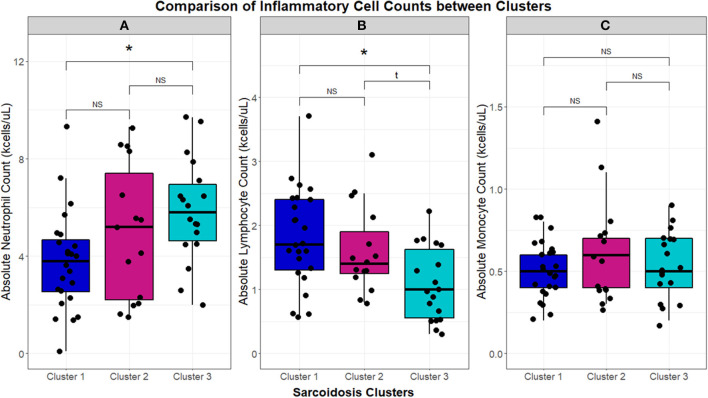
Box and whisker plots demonstrating median and interquartile ranges (kcells/μL) of circulating inflammatory cells in the UIC-Sarcoidosis cohort clusters. Comparisons between clusters with Kruskal-Wallis tests were performed and, if significant (p < 0.05), were followed by post-hoc analysis with Dunn's test and Benjamini-Hochberg (BH) adjustment for multiple comparisons. Kruskal-Wallis test significance is displayed in the corresponding panel and significance of Dunn's test, denoted with an asterisk (*), is displayed above the brackets linking respective box and whisker plots. Specifically, neutrophils (A) were found significantly elevated in Cluster 3 compared to Cluster 1 (BH-adjusted p = 0.0141). Conversely, lymphocytes (B) were found significantly reduced in Cluster 3 compared to Cluster 1 (BH-adjusted p = 0.0207). Neutrophil and lymphocyte counts between Cluster 1 and Cluster 2 and between Cluster 2 and Cluster 3 were comparable. Monocytes (C) did not show any significant differences between clusters. NS, non-significant.